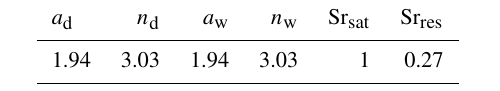
Table 2. Hydraulic parameters of two-mica quartz schist and chlo- rite schist.